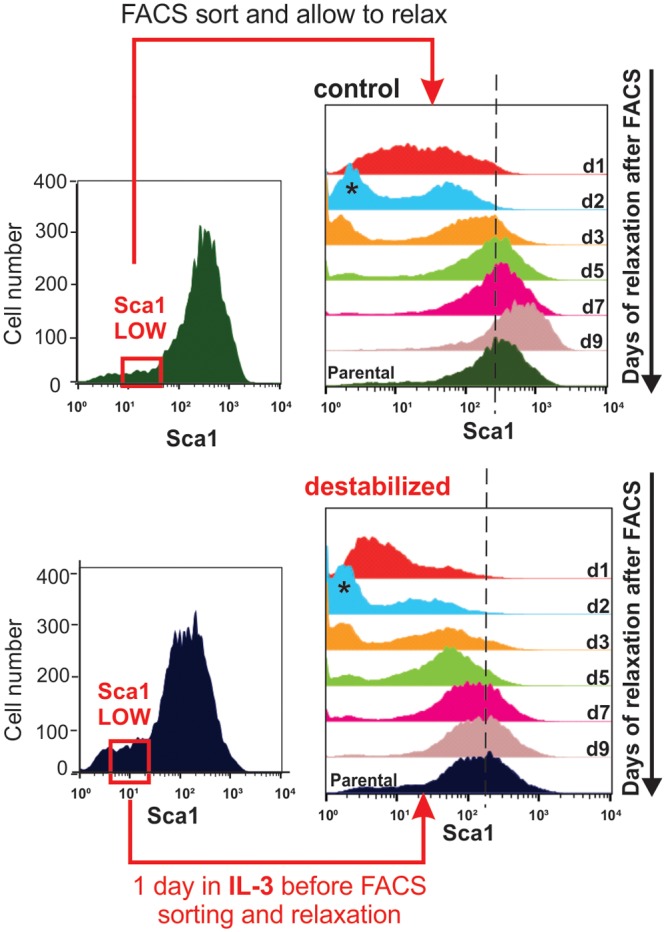
Critical Slowing down of state relaxation during fate commitment.Apparent critical slowing down of relaxation and restoring of parental distribution of the sorted Sca1-low outlier fraction in the treated population. Clonal EML progenitor cells were stimulated (top) with GM-CSF/IL-3 or not (bottom), and cells with lowest 15% Sca1 expression were FACS-sorted one day after stimulation.